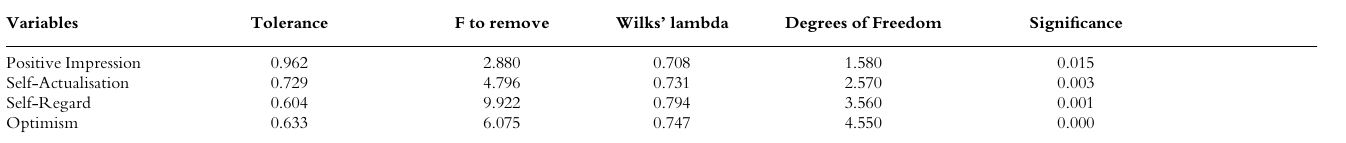
TABLE 2 VARIABLESEXTRACTEDIN ORDEROF